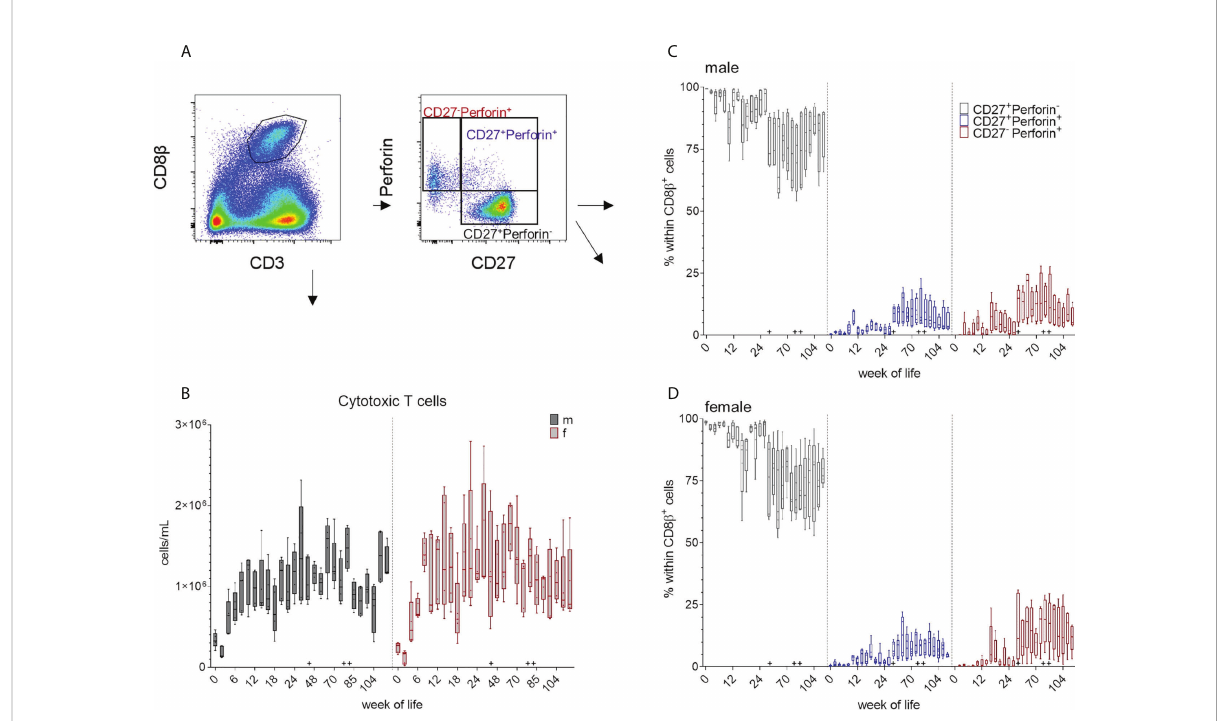
FIGURE 6 (A) Gating strategy to distinguish CD8 b + T cells and CD27/perforin-de fi ned subsets on the basis of a representative EGM (male, 18 weeks of age). (B) Total numbers of CD3 + CD8 b + T cells were determined as described above over a study period of 126 weeks. Sexes are represented by black (male) and red colors (female). (C, D) Development of the relative composition of CD27/perforin-de fi ned phenotypes over a study period of 126 weeks (C) males, (D) females. + marks the fi rst bleeding time point after transfer and vaccination, ++ marks the fi rst bleeding time point after booster